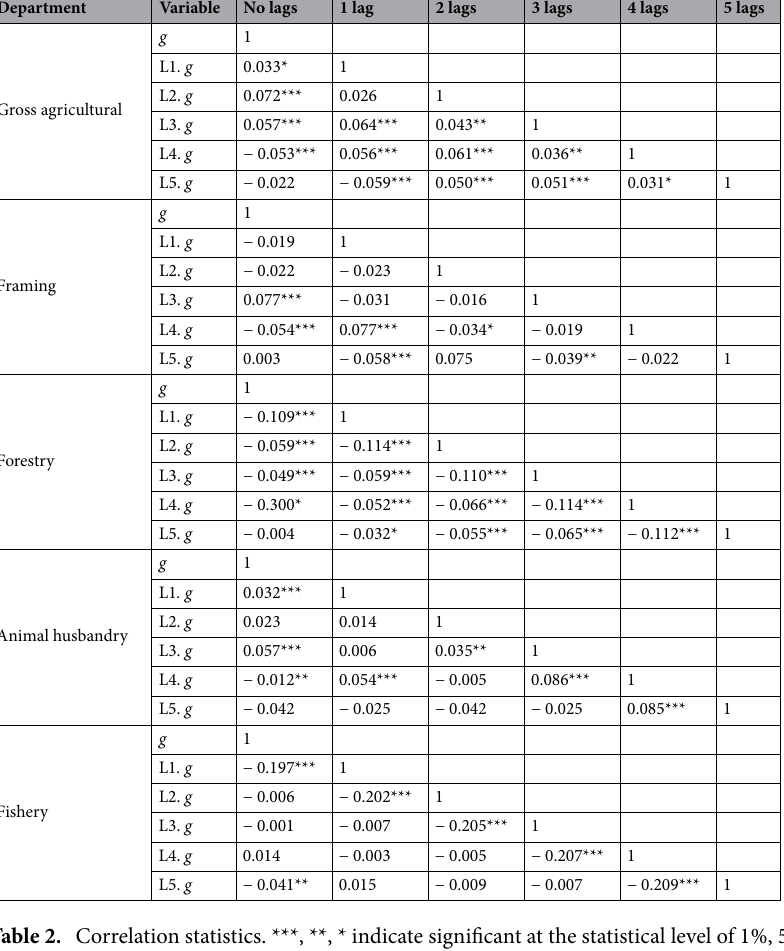
No lags 1 lag 5 lags 10 lags